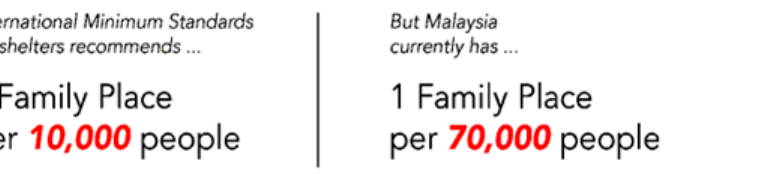
Figure 2. The Shelter Needs of Domestic Violence Survivors and the Availability and Accessibility and Related Services and Kuala Lumpur, Policy paper no. 1,